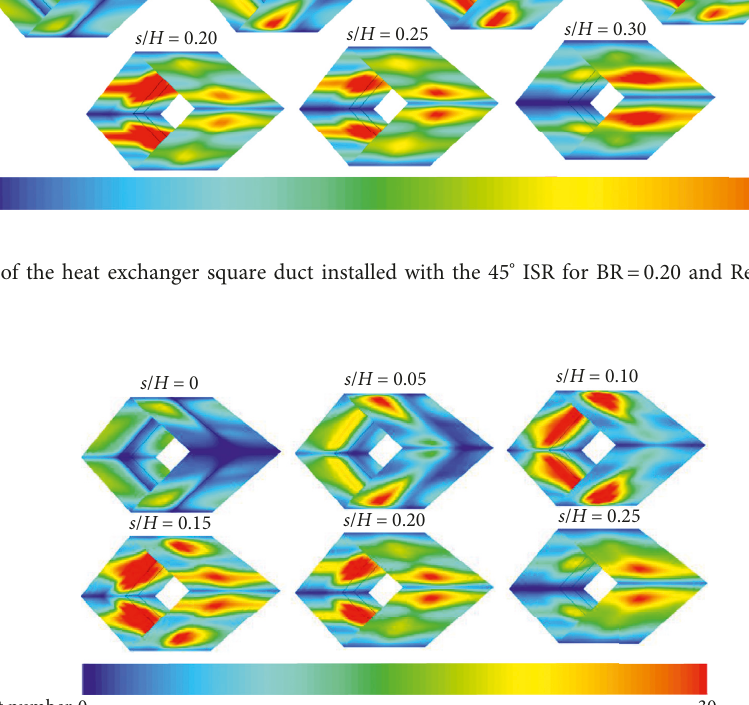
° ISR for BR � 0.25 and Re � 800.